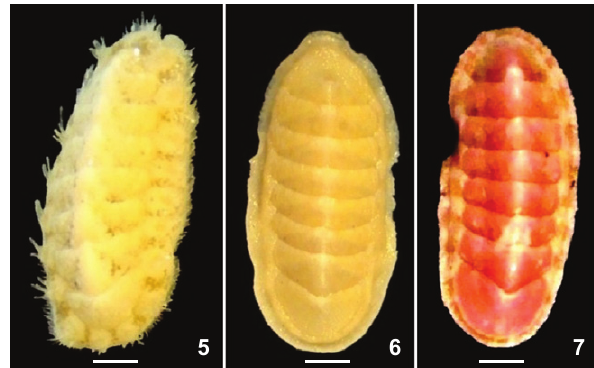
Figures 5-7. Polyplacophora species from reef ecosystems on the Maceió coast, Alagoas: (5) Acanthochitona terezae , UFALMOL 0406; (6) Ischnochiton striolatus , UFALMOL 0415; (7) Ischnoplax pectinata , UFALMOL 0434. Scale bars: 5 = 1 mm, 6 = 2 mm, 7 = 5 mm. Photos M.D. Correia.